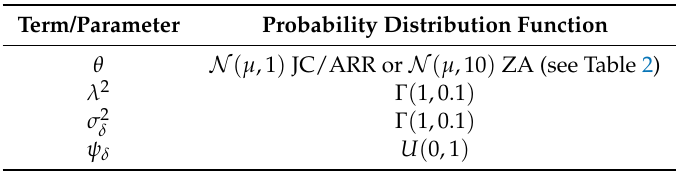
Table 1. Prior probability